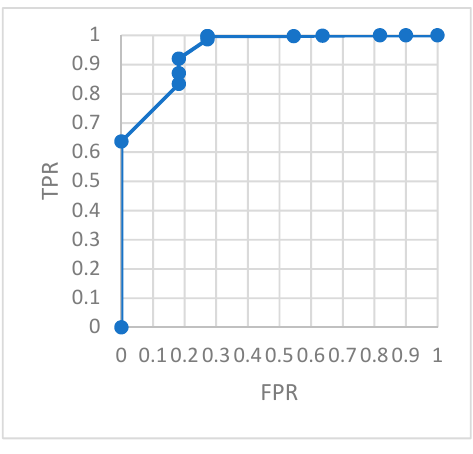
Figure 21. ROC of GRU-AE in test set 2.